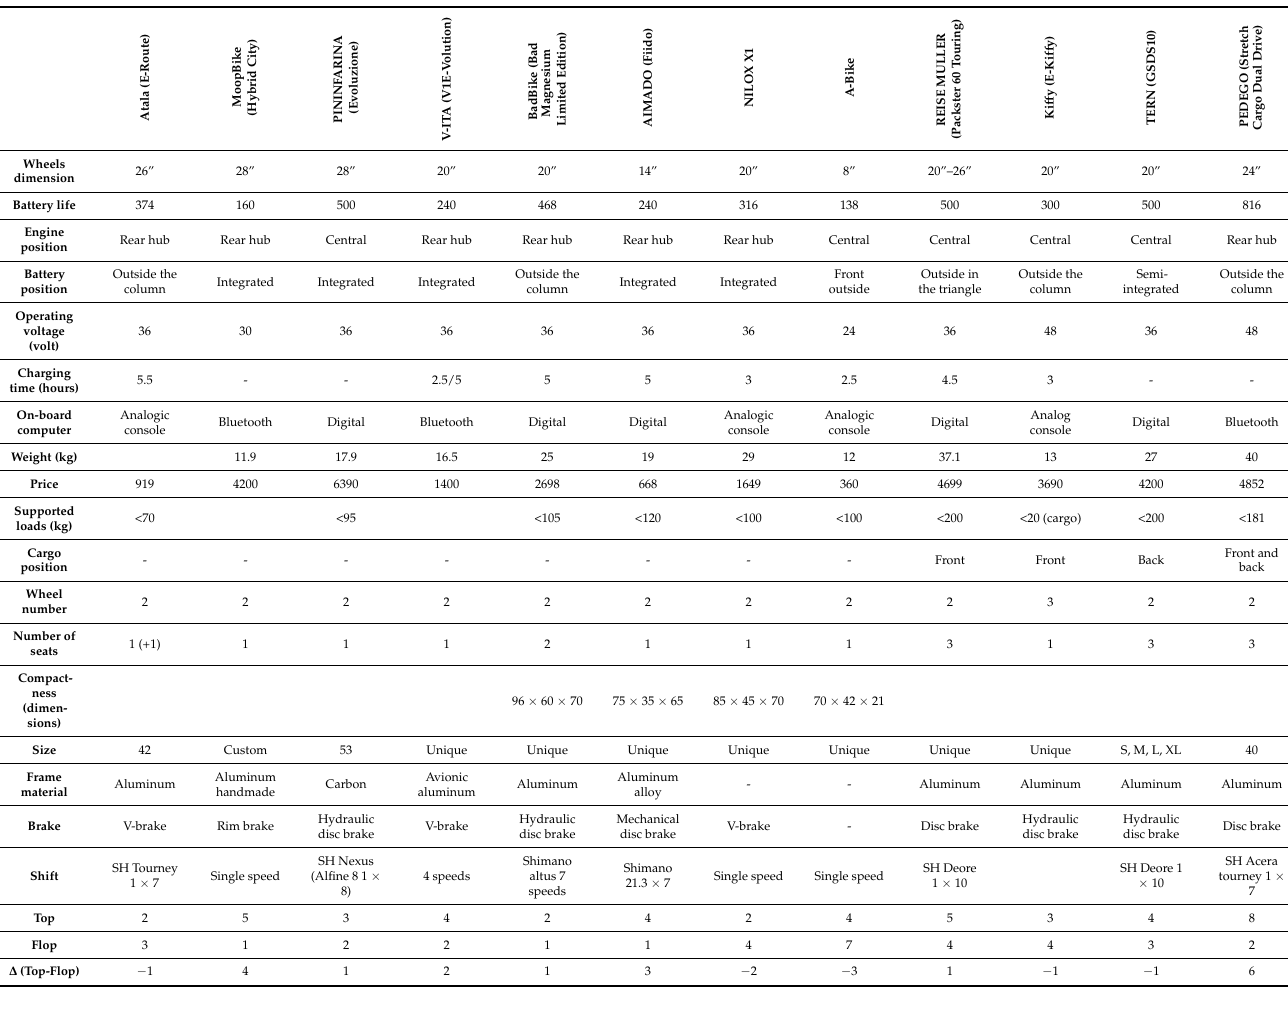
Table 3. Benchmarking table among concurrent products.